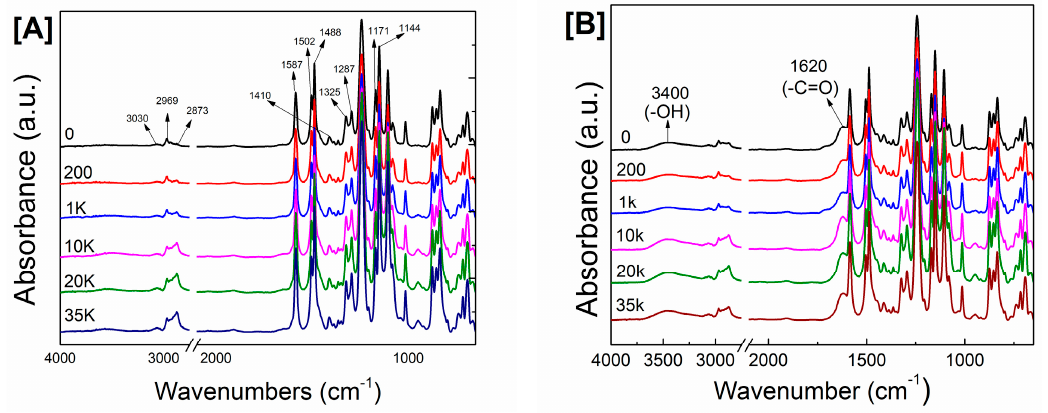
Figure 1. ATR-FTIR spectra of: ( A ) PSf membranes; and ( B ) TFC membranes with varying PEG molecular weights.